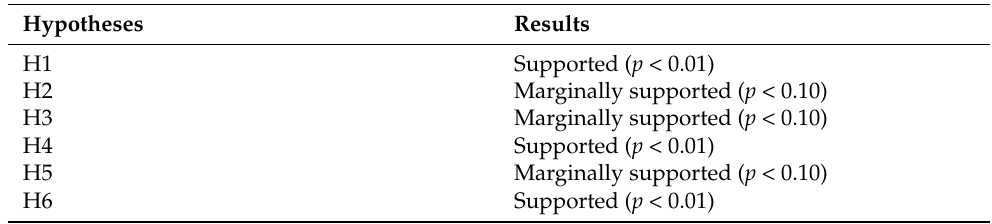
Table 7. Results of hypothesis